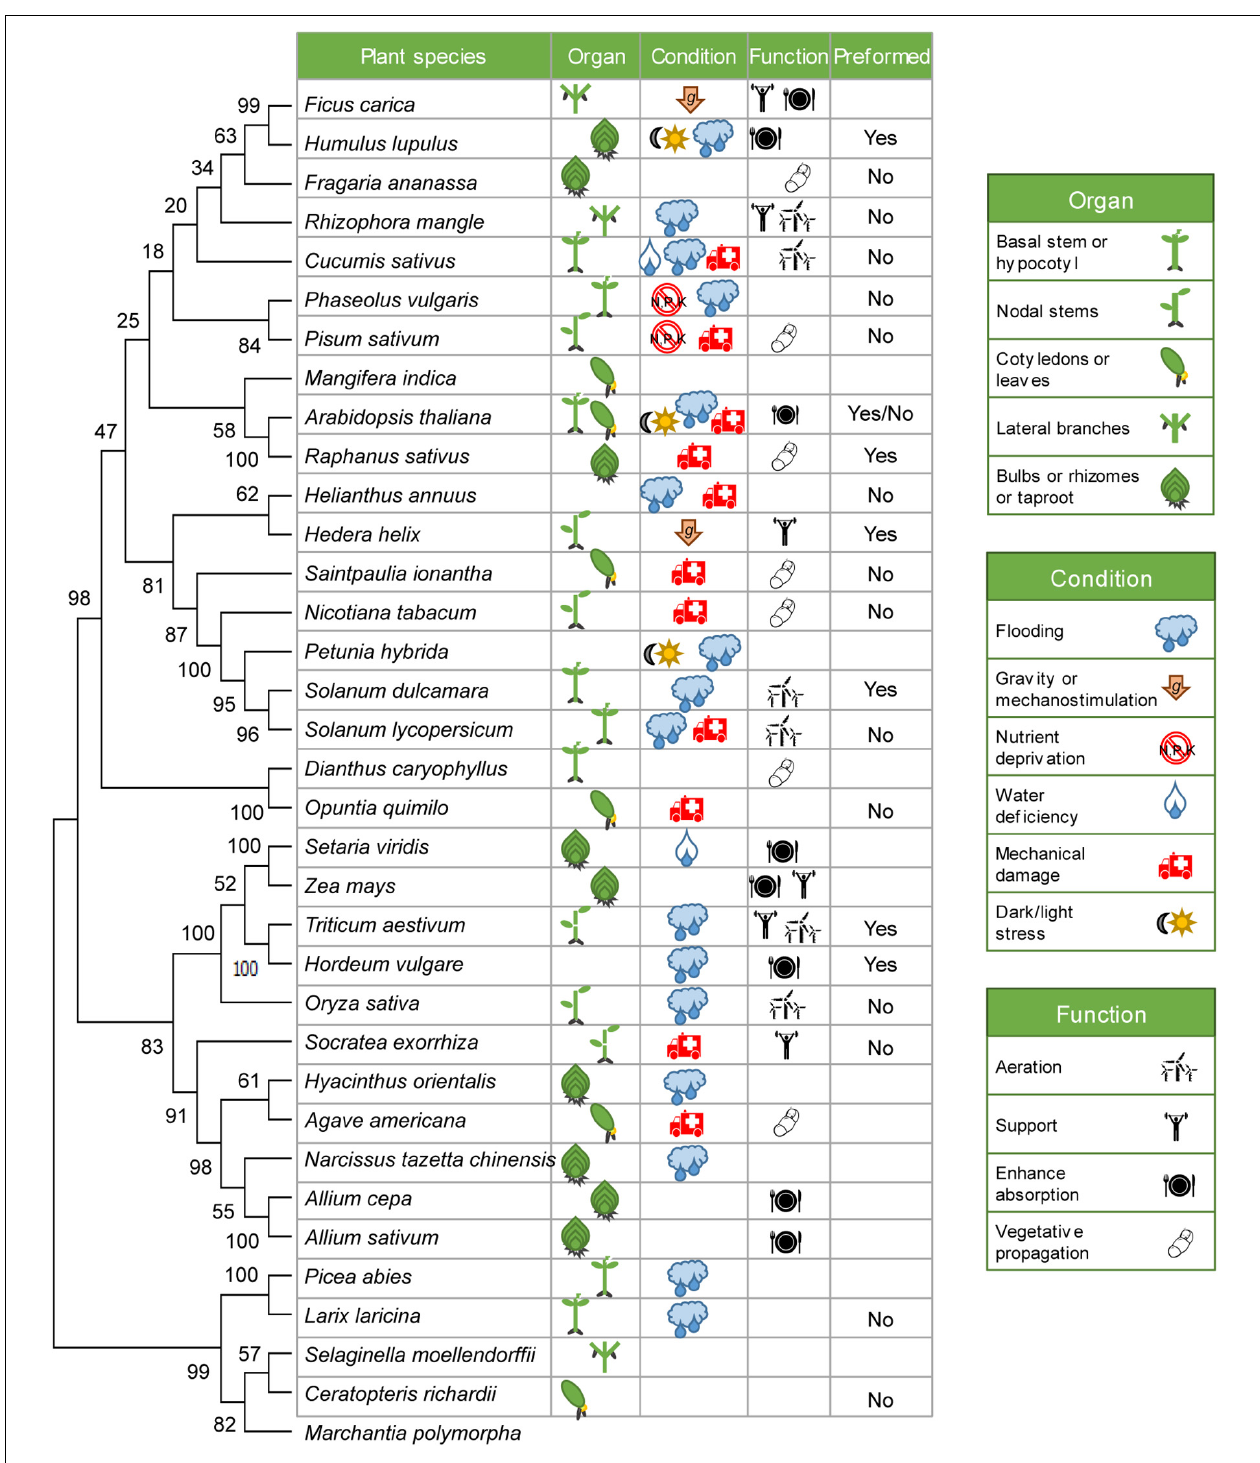
FIGURE 1 | Evolutionary constraints of AR formation. rbcL nucleotide sequences from 34 representative plant species where AR formation has been experimentally described were retrieved from NCBI ( Supplementary Dataset ) and aligned by the ClustalW algorithm with MEGA-X (Kumar et al., 2018). The liverwort Marchantia polymorpha has been used here as an outgroup. The consensus phylogenetic tree was inferred by using the maximum likelihood (ML) method and Jones-Taylor-Thornton (JTT) model from 500 bootstrap replicates. The percentage of replicate trees in which the associated taxa clustered together in the bootstrap test are shown next to the branches. Some details of their AR system of each species are provided next to the species name.